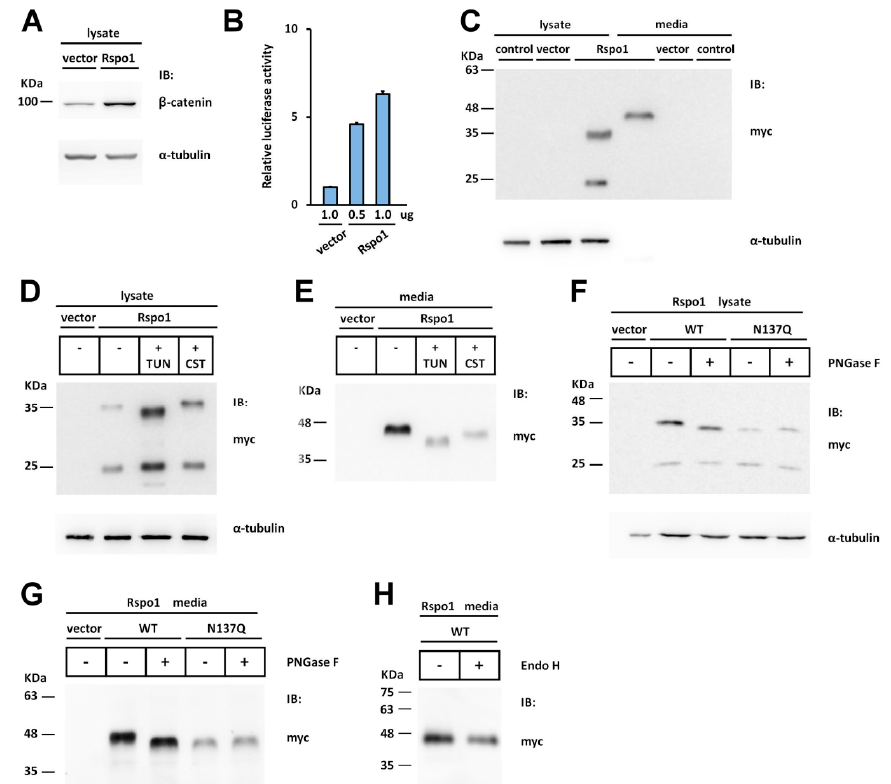
Figure 1. Human Rspo1 is N-glycosylated at Asn137. ( A , C ) Cell lysates or conditioned media from control vector or myc-tagged human Rspo1-transfected HEK293T cells were analyzed for endogenous soluble β -catenin ( A ) or the expression of myc-tagged human Rspo1 ( C ) by Western blot. ( C ) “Control” and “vector” indicated un-transfected control and empty vector-transfected control, respectively; ( B ) SuperTopFlash plasmids were co-transfected with either the indicated amounts of control vector or myc-tagged Rspo1-expressing plasmids. Renilla luciferase, driven by the thymidine kinase gene promoter, was included as a transfection control; ( D , E ) Human Rspo1 was transiently expressed in HEK293T cells in the presence of tunicamycin (TUN) or castanospermine (CST). The cell lysates ( D , 15 µ g per lane) and conditioned media ( E , 23 µ L per lane) were analyzed by Western blot; ( F , G ) The cell lysates ( F ) and conditioned media ( G ) of wild type (WT) human Rspo1 or N137Q mutant-transfected HEK293T cells were treated with (+) or without ( − ) PNGase F; ( H ) The conditioned media from WT Rspo1-transfected cells were treated with (+) or without ( − ) Endo H. α -tubulin was used as a loading control for the cell lysates in each blot.